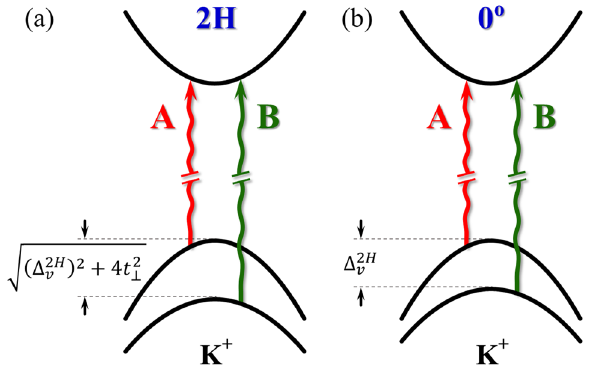
Figure 4. Diagram of relevant subbands in the CB and VB at the K + point of the Brillouin zone in the bilayers MoS 2 with twist angle of ( a ) 60 ◦ (2H) and ( b ) 0 ◦ . The red and green wavy lines show the A and B exciton transitions. The t ⊥ and (cid:31) 2H v represent the interlayer hopping term and the spin-orbit VB splitting without interlayer coupling, respectively.